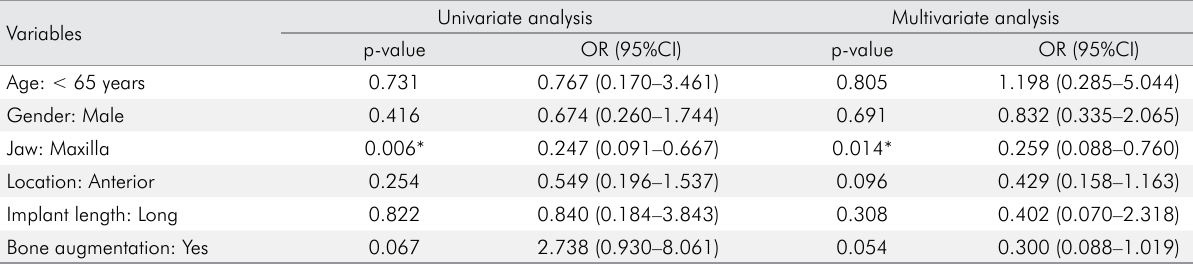
Table 2. Univariate and multivariate risk factor analyses for implant failure using GEE.